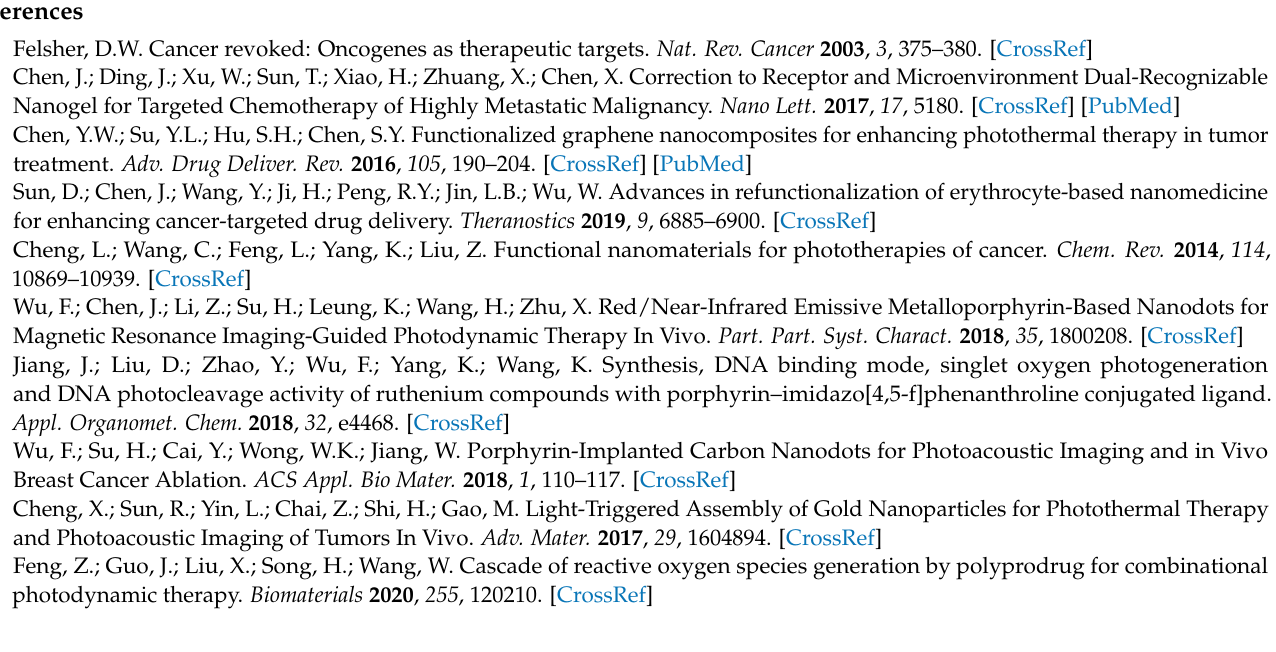
Figure S4: The ESI-MS of structure 9; Figure S5: The 1 HNMR of PTA; Figure S6: The MALDI-TOF of PTA; Figure S7: The cell viability of A549 cells incubated with different concentrations of TPA-NPs for a period of 24 and 96 h in the